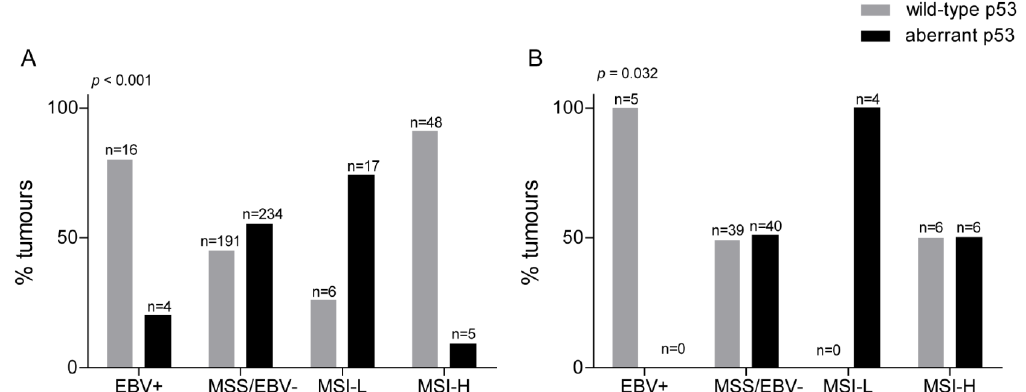
Figure 3. Association of p53 expression with MSS / EBV − , MSI-L, MSI-H, and EBV + tumor subtypes. The comparison of the four molecular subgroups with p53 expression is shown in the resection specimens ( A ) and the biopsy cohort before CTx ( B ). EBV( + ), Epstein–Barr virus-positive; EBV( − ), Epstein–Barr virus-negative; MSI-L, low microsatellite instability; MSS, microsatellite stable; MSI-H, high microsatellite instability; p -value of chi-squared test.